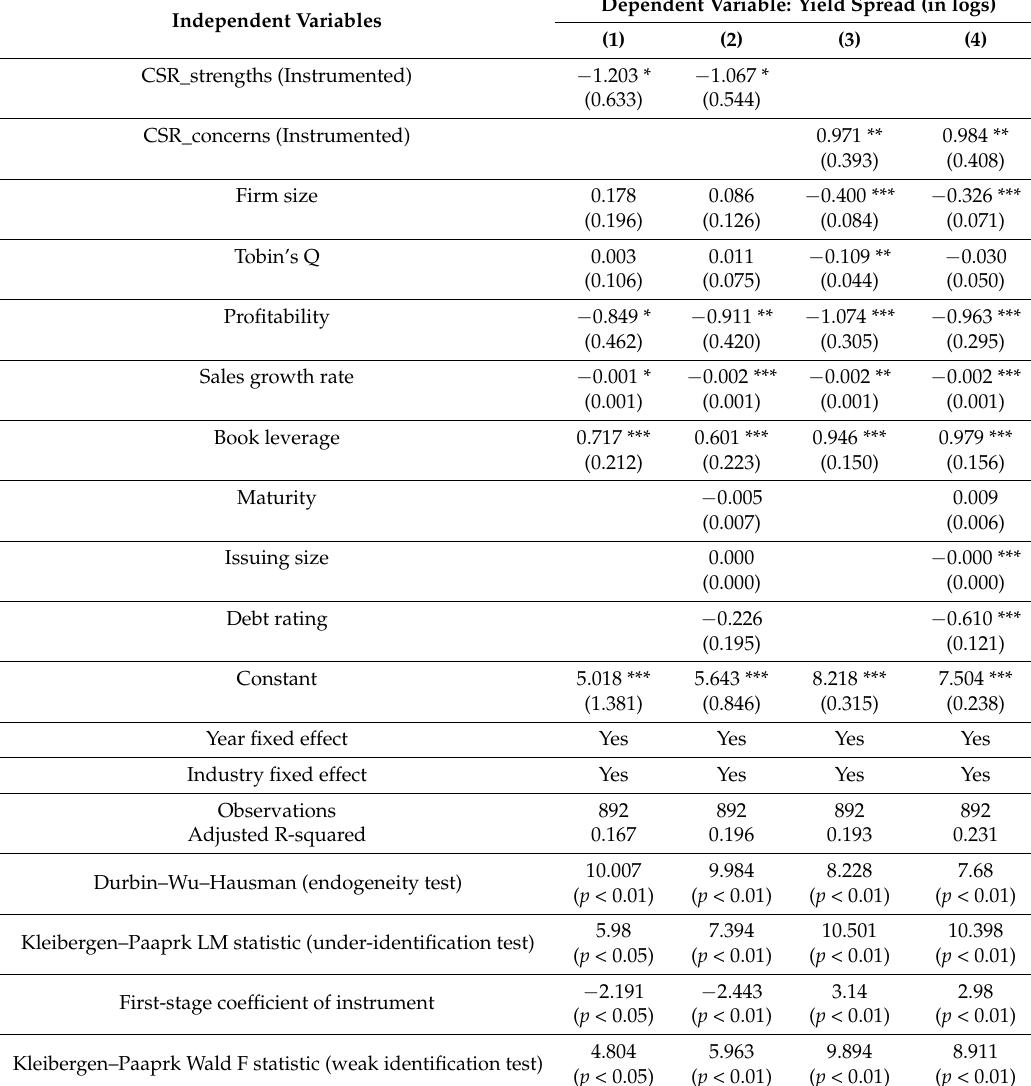
Table 4. Addressing the endogeneity issue: an instrumental variable